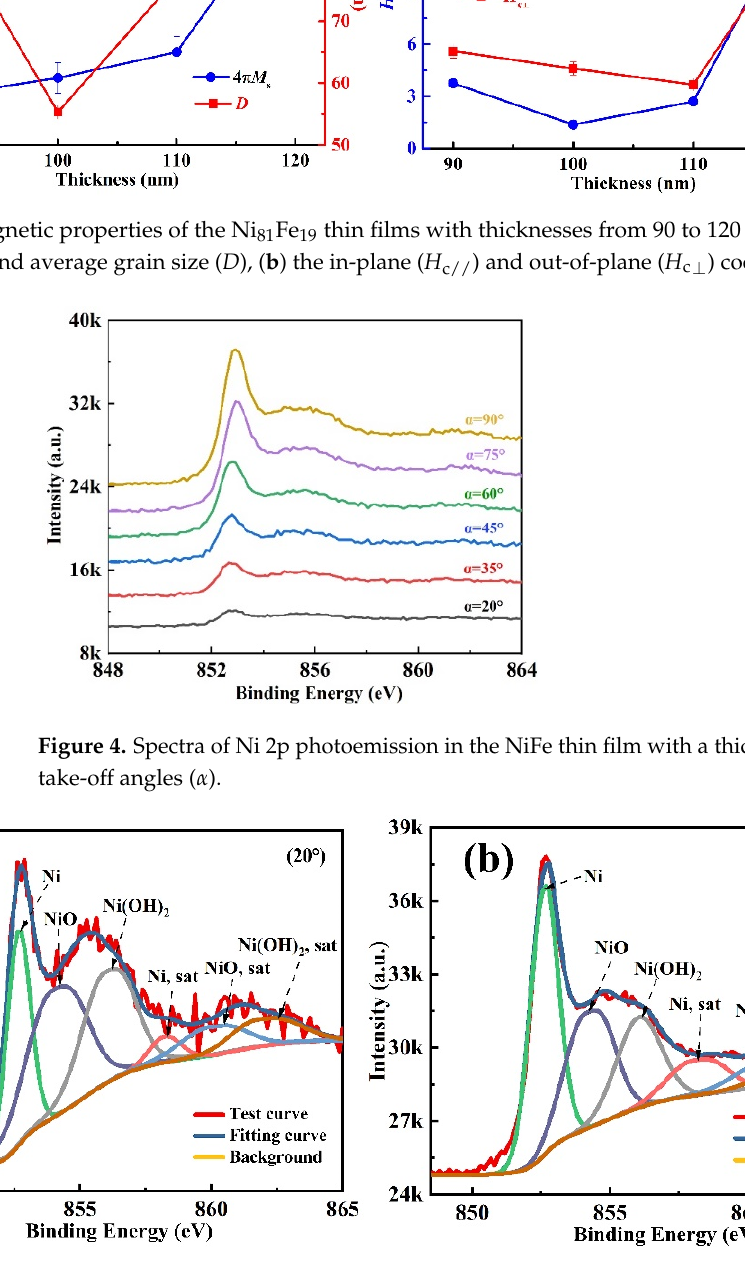
Figure 5. ARXPS spectra of Ni 2p photoemission and the fitting results for NiFe thin film with a thickness of 100 nm at different take-off angles: ( a ) 20° and ( b ) 90°.